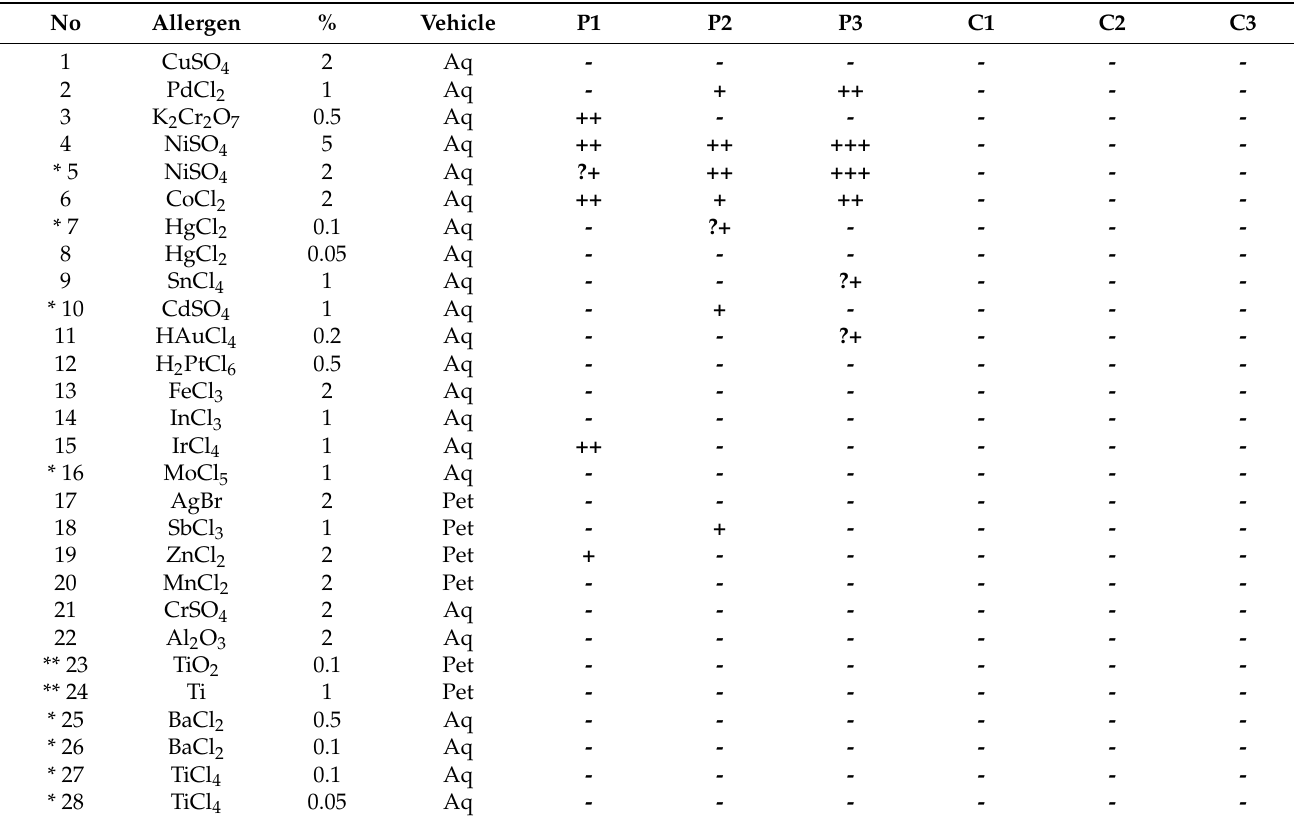
Table 2. Allergen type and level of allergy 7 days after the patch test. Clinical scoring of inflammatory reactions induced by metals in all subjects. ( n =